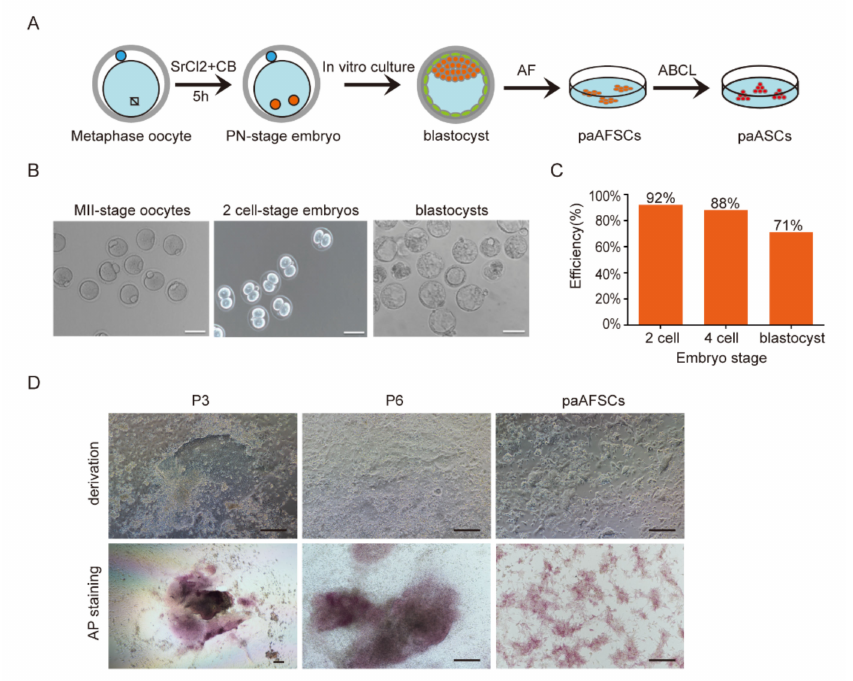
Figure 1. Derivation of paAFSCs from parthenogenetic diploid blastocysts: ( A ) Schematic of deriva- tion of paAFSCs and paASCs. ( B ) The development of parthenogenetic diploid blastocysts from MII stage oocytes of ICR female mice; scale bars: 100 µ m. ( C ) The developmental rates of partheno- genetic 2-cell, 4-cell, and blastocyst-stage embryos from MII oocytes of ICR female mice in vitro. ( D ) The derivation process and AP staining of paAFSCs from parthenogenetic diploid blastocysts; P3: passage 3; P6: passage 6; scale bars: 100 µ